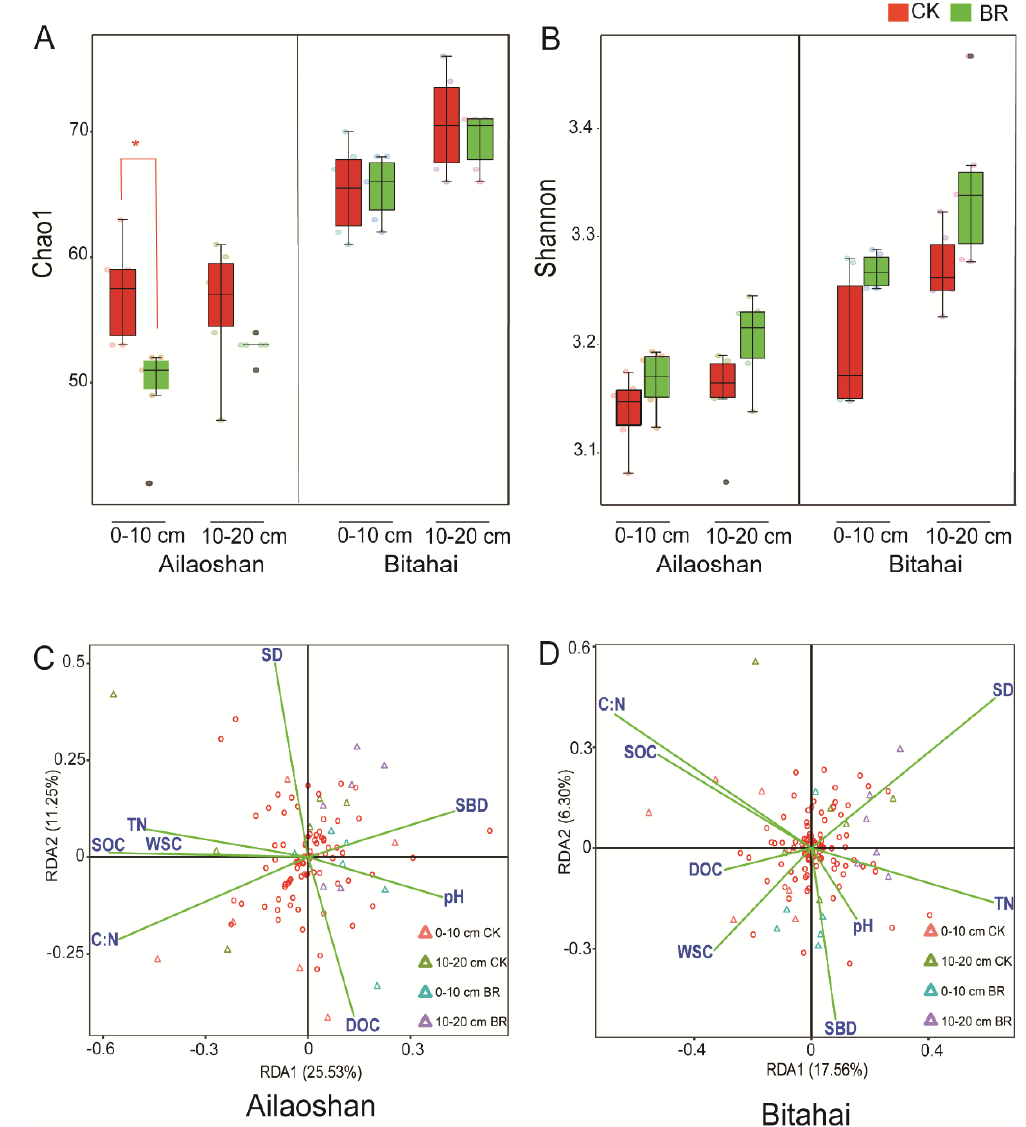
Figure 4. Effects of bryophyte removal (CK: no bryophyte removal; BR: bryophytes removed) and soil depth (0–10 and 10–20 cm) on soil microbial alpha diversity in Ailaoshan ( A ) and Bitahai ( B ). The red star in A means significant difference between treatments. Values are the means ± SE of six plots. Redundancy analysis (RDA) was used to study the relationship between soil physicochemical properties and microbial community composition in Ailaoshan ( C ) and Bitahai ( D ), the red circles represent the PLFA of microorganisms, the green lines represent physical and chemical factors, and the sample groups are represented by colored triangles.